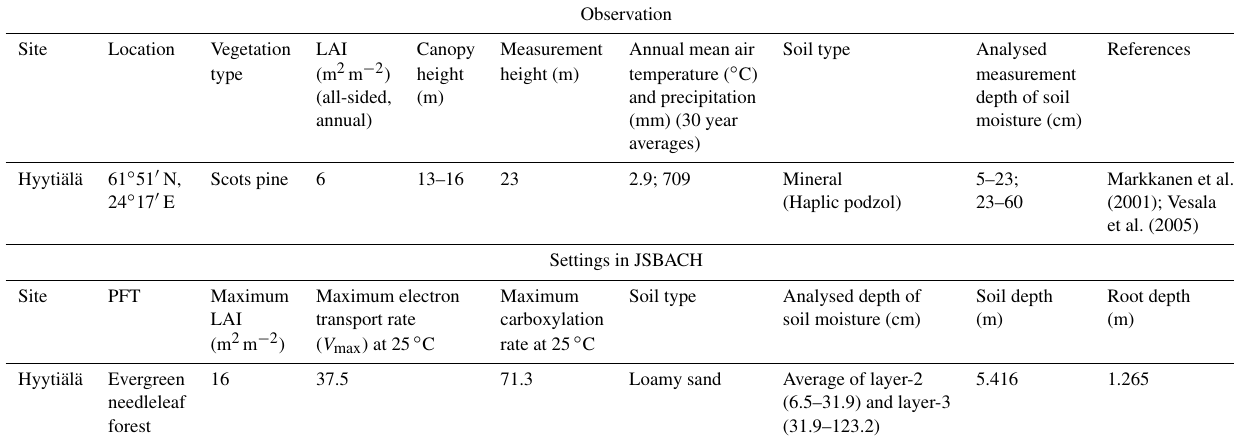
Table 1. Key characteristics relevant to this study from observation and the parameter settings in the JSBACH site level simulation at the Hyytiälä